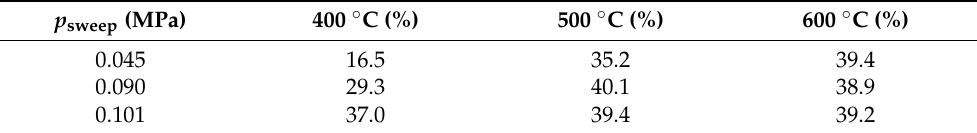
Table 4. Relationship between CO 2 conversion and p sweep with change in reaction temperature. p sweep (MPa)